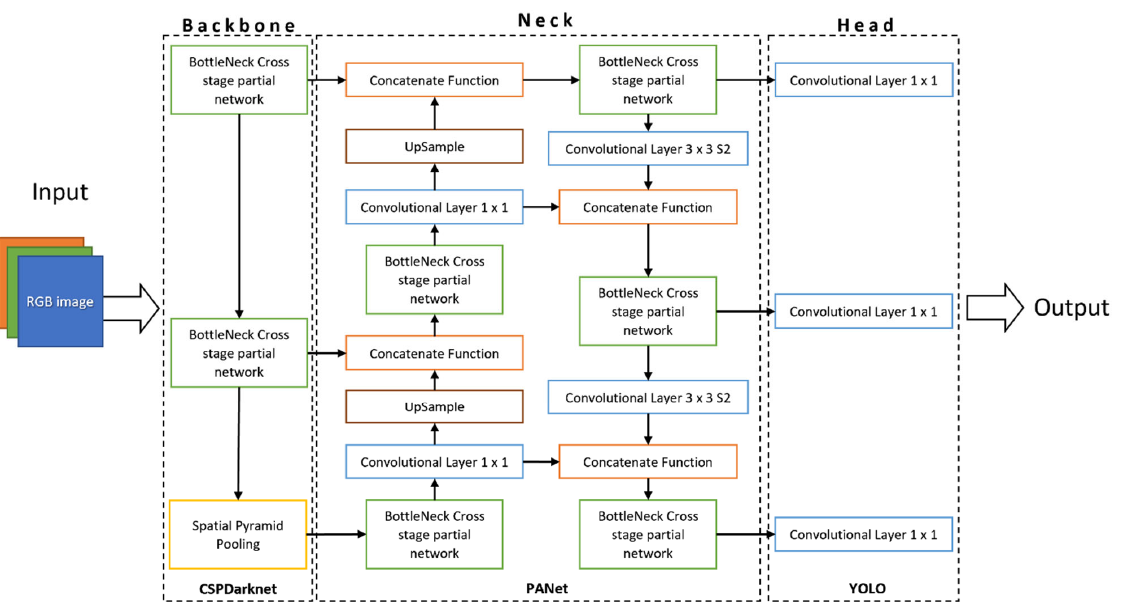
Figure 4. YOLOv5 network architecture split into three main parts: Backbone, Neck, and Head.